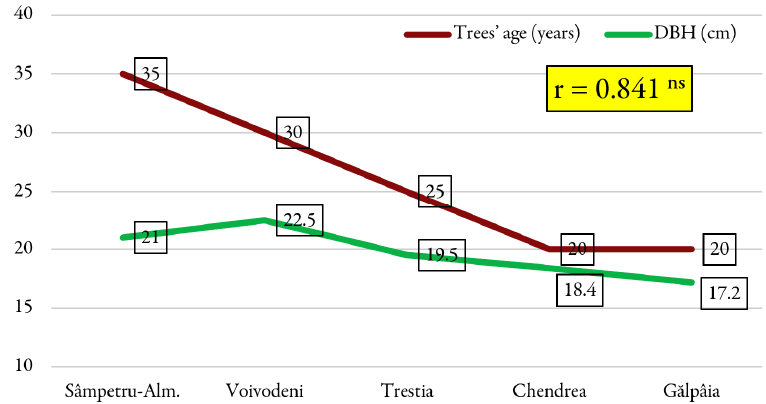
Figure 4. Coefficient of correlation between trees’ age (years) and diameter at breast height (DBH) of the R. pseudoacacia plus trees selected from the five